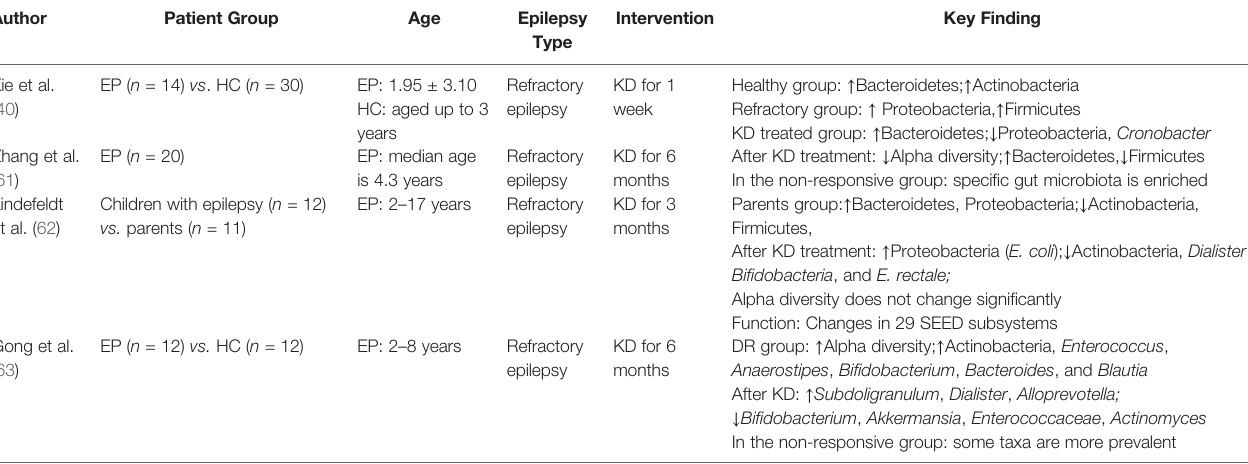
TABLE 2 | Summary of previous study on intestinal microbiota in epileptic patients with KD